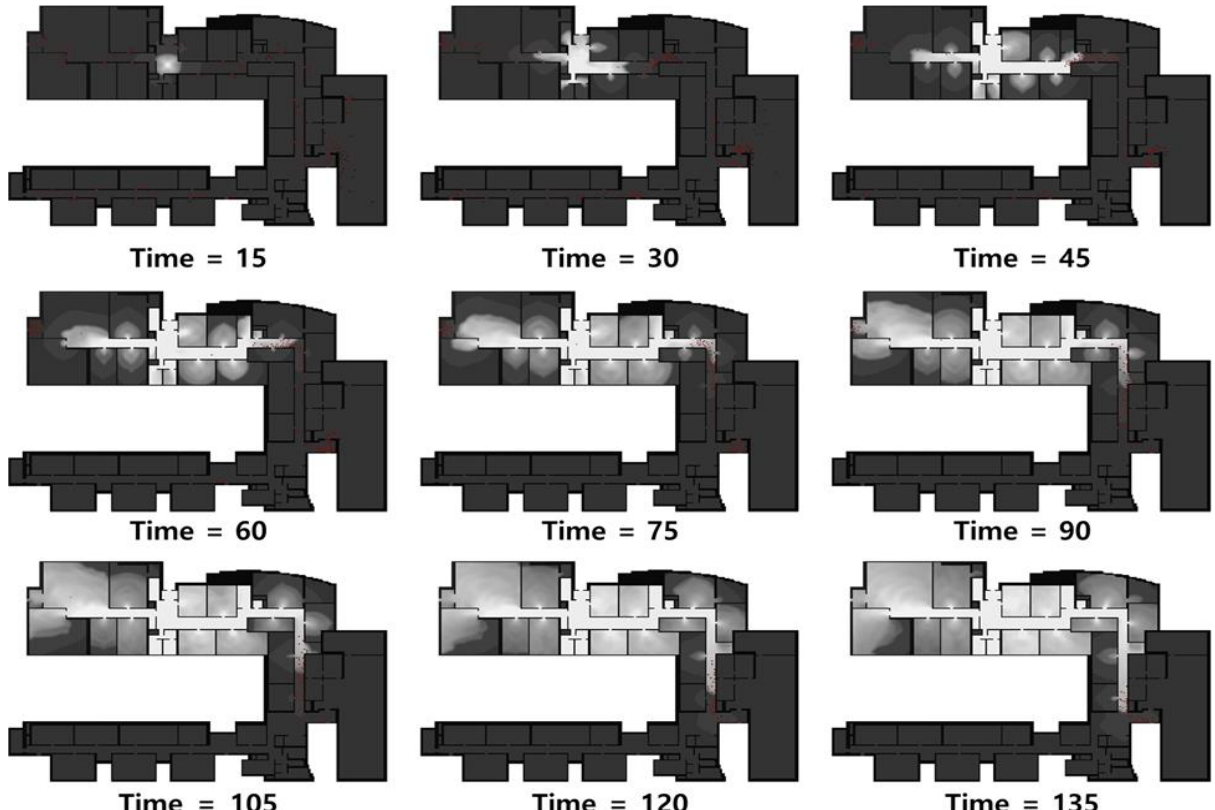
Figure 11. The simulation on situation